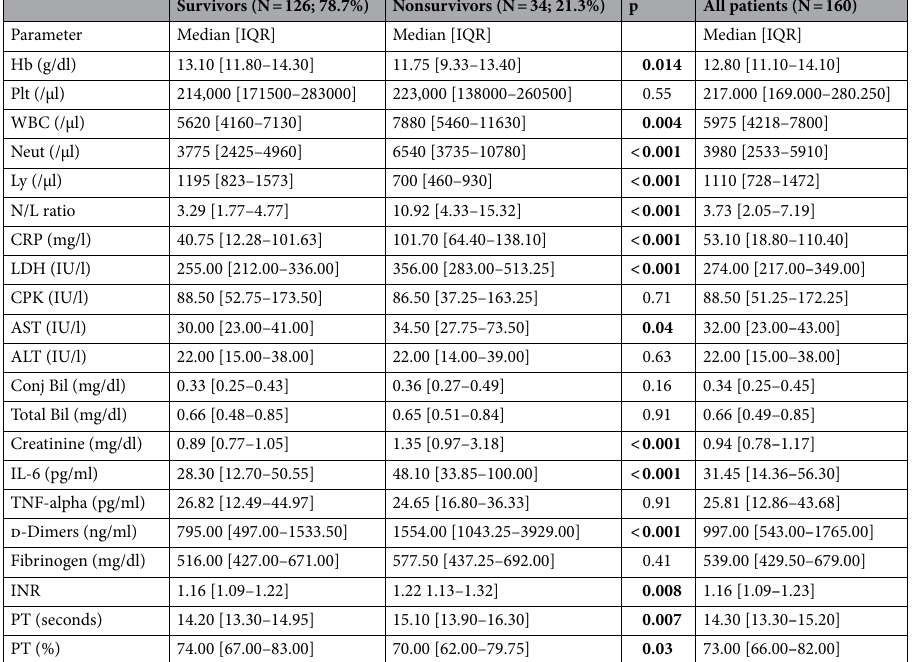
Table 4. Laboratory findings at baseline in the study population. Statistically significant p values are highlited in bold. Reference values: Hb (g/dl): 12.00–16.00; Plt (/µl): 150,000–450,000; WBC (/µl): 4300–10,800; CRP (mg/l): 0–5.00; LDH (IU/l): 125.00–220.00; CPK (IU/l): 29.00–168.00; AST (IU/l): 5.00–34.00; ALT (IU/l): 0–55.00; Conj Bil (mg/dl): < 0.50; Total Bil (mg/dl): < 1.20; Creatinine (mg/dl): 0.55–1.02; IL-6 (pg/ml): <